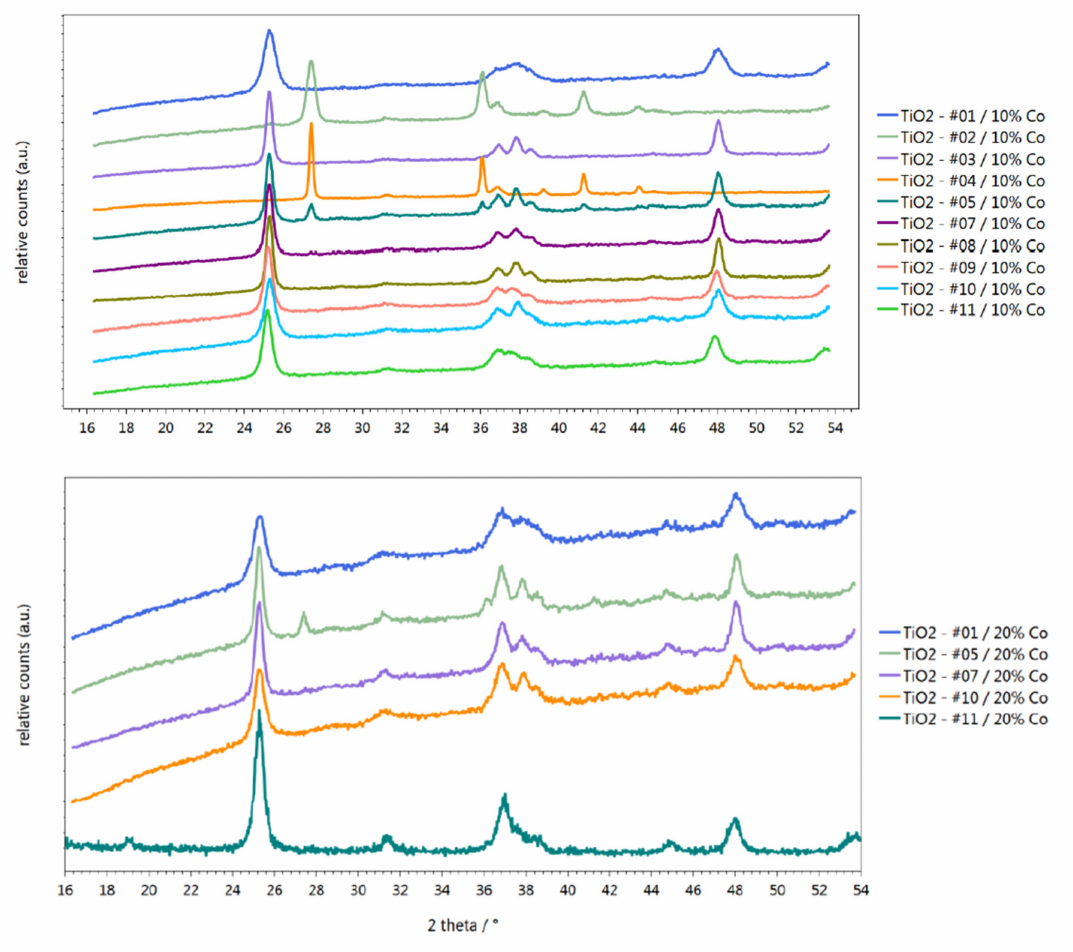
Figure 2. XRD analysis of Co supported on TiO 2 with 10 wt % (top) and 20 wt % (bottom) Co